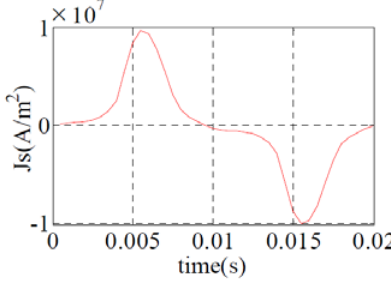
Figure 7. Measured current density: 50Hz.